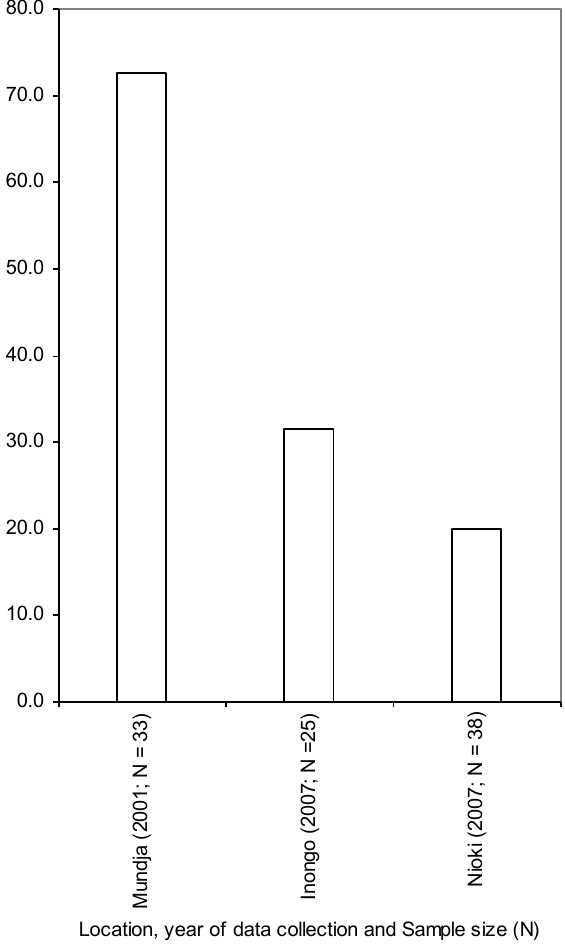
Figure 2. Percentage of C. chrysogaster specimens recorded in bushmeat markets from three different